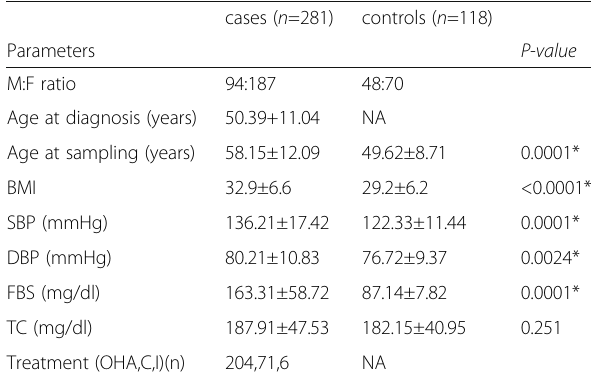
Table 1 Clinical and biochemical characteristics of case and control